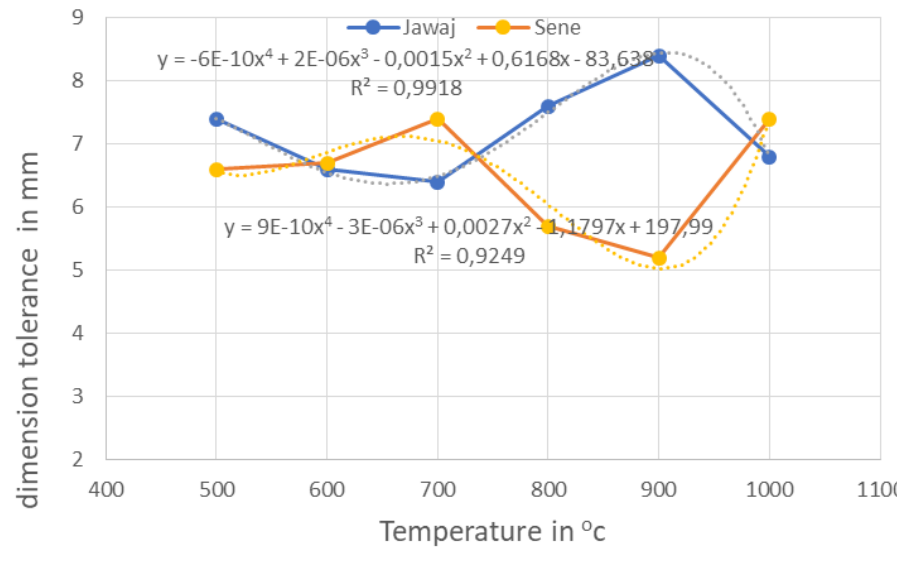
Figure 10: Average dimension tolerance test results along the width 60